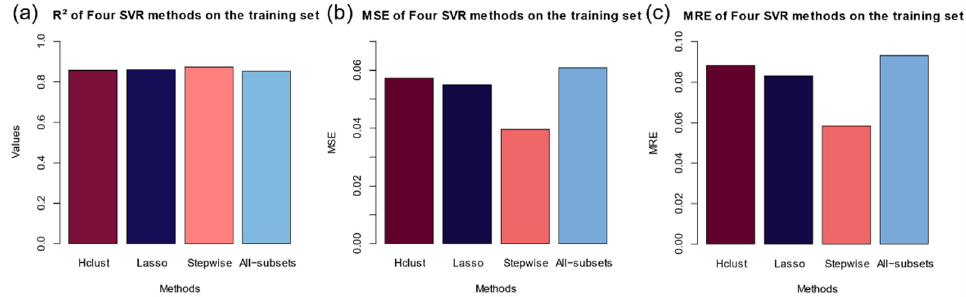
Figure 7. The R 2 , MSE and MRE on the training set. ( a ) R 2 ; ( b ) MSE; ( c ) MRE. Table 8. The R 2 , MSE and MRE of the four methods on the training set. Methods